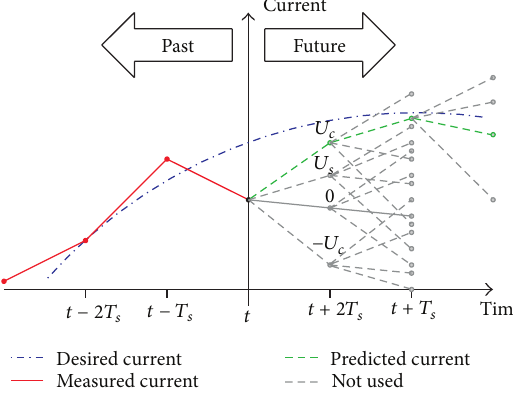
Figure 4: Principle of the complete applied MPC strategy.